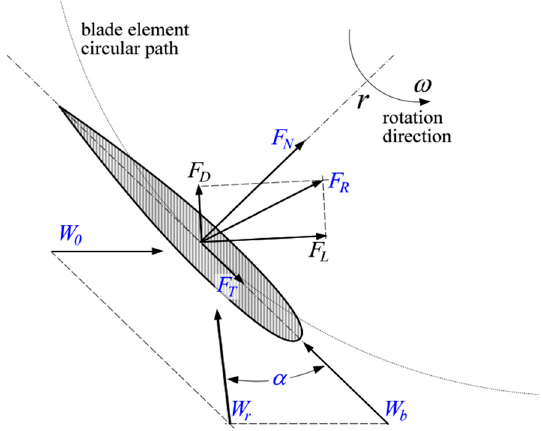
Figure 3. Velocity and force components for a DT ‐ VAWT.